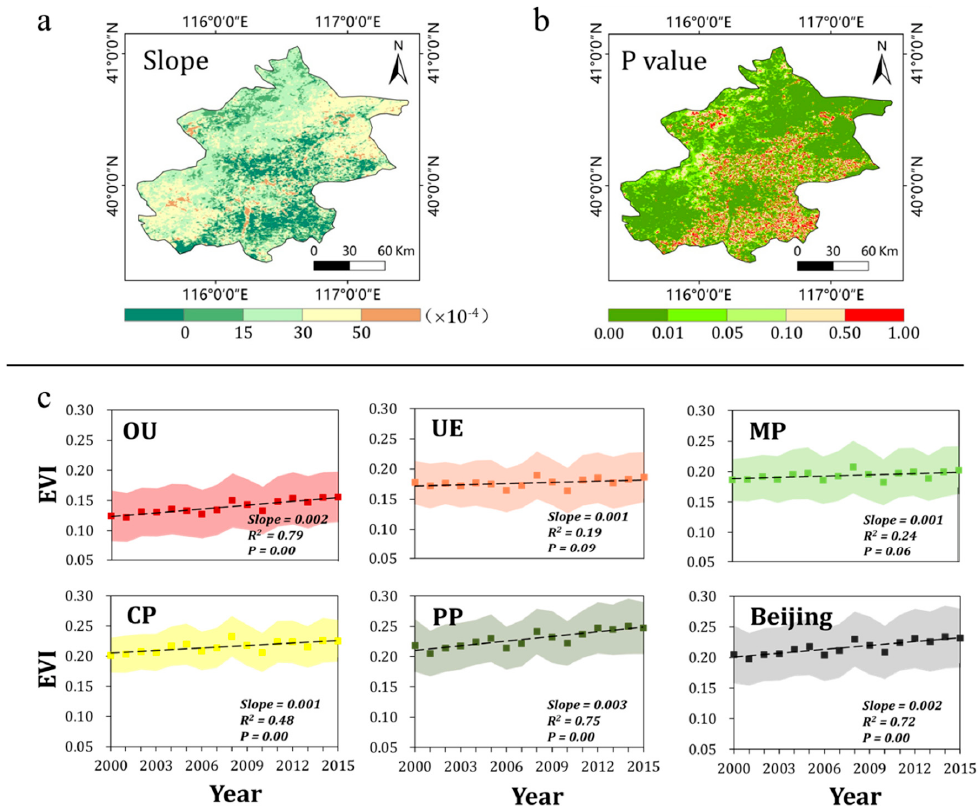
Figure 5. Spatial pattern and temporal changes of enhanced vegetation index (EVI) in Beijing. a and b are the spatial patterns of annual trend and significant test (P value); c is the annual change with standard deviation (shadow zones with different colors) of various land cover types for EVI from 2000 to 2015.